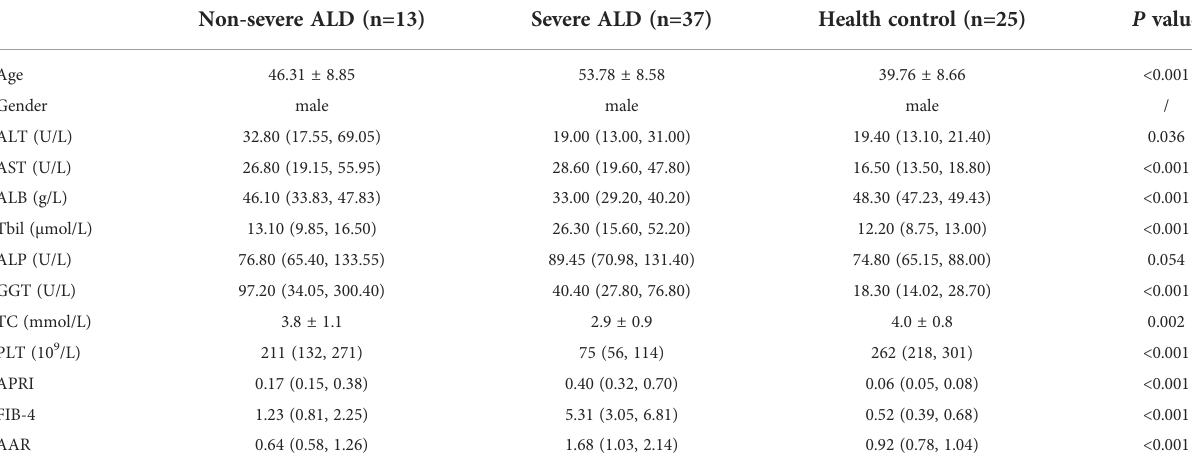
TABLE 3 Clinical characteristics of participants in the validation